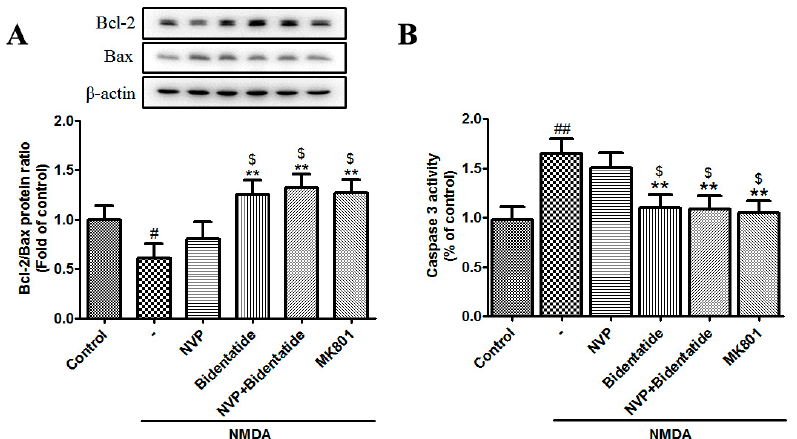
Figure 5. Involvement of NR2B-containing NMDA receptors in bidentatide regulation of apoptosis-related protein expression: ( A ) representative Western blot images and the related bar graph showing the Bcl-2/Bax expression ratio in primary cultured hippocampal neurons upon different treatments, as mentioned in Figure 4A; ( B ) bar graph showing the activity of caspase 3 in primary cultured hippocampal neurons upon different treatments, as mentioned in Figure 4A; # p < 0.05 and ## p < 0.01 verses control; ** p < 0.01 verses NMDA alone; $ p < 0.05 versus pretreatment with NVP-AAM077 plus NMDA.